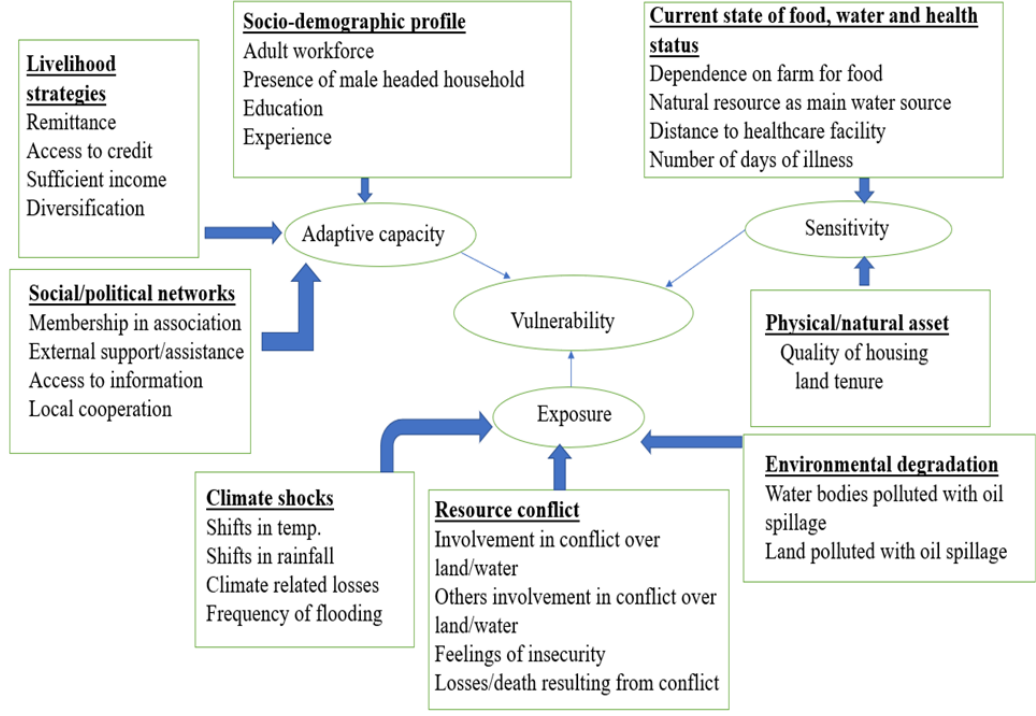
Figure 3. Analytical framework for vulnerability assessment . Adapted from [1].